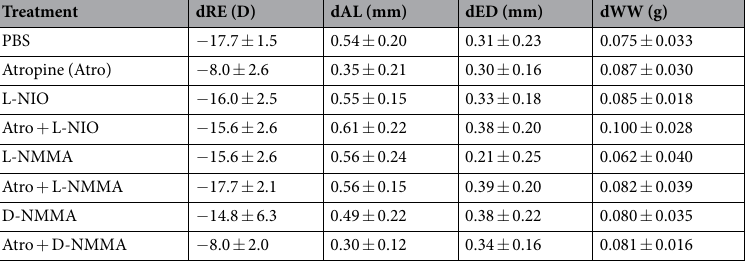
Table 1. The effects of atropine (240 nml), NOS inhibitors (6 nmol), and D-NMMA (6 nmol) on the mean difference between experimental (goggled) eyes and control (non-goggled) eyes of various eye parameters. * dRE: difference refractive errors; dAL: difference axial lengths; dED: difference equatorial diameters; dWW: difference wet weights. Values represented as mean ± SD.